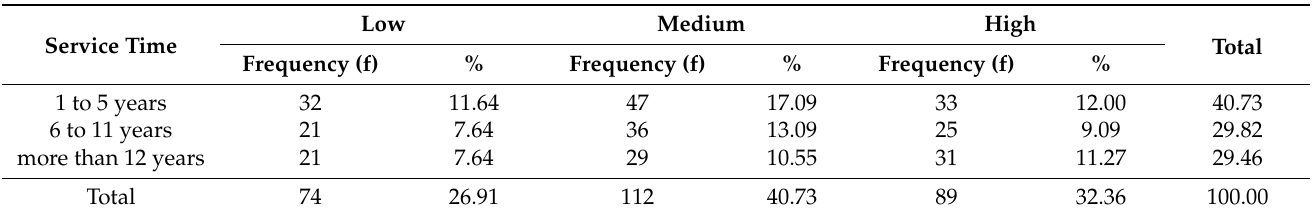
Table 7. Level of the remote work variable in Peruvian workers during the COVID-19 pandemic, according to service